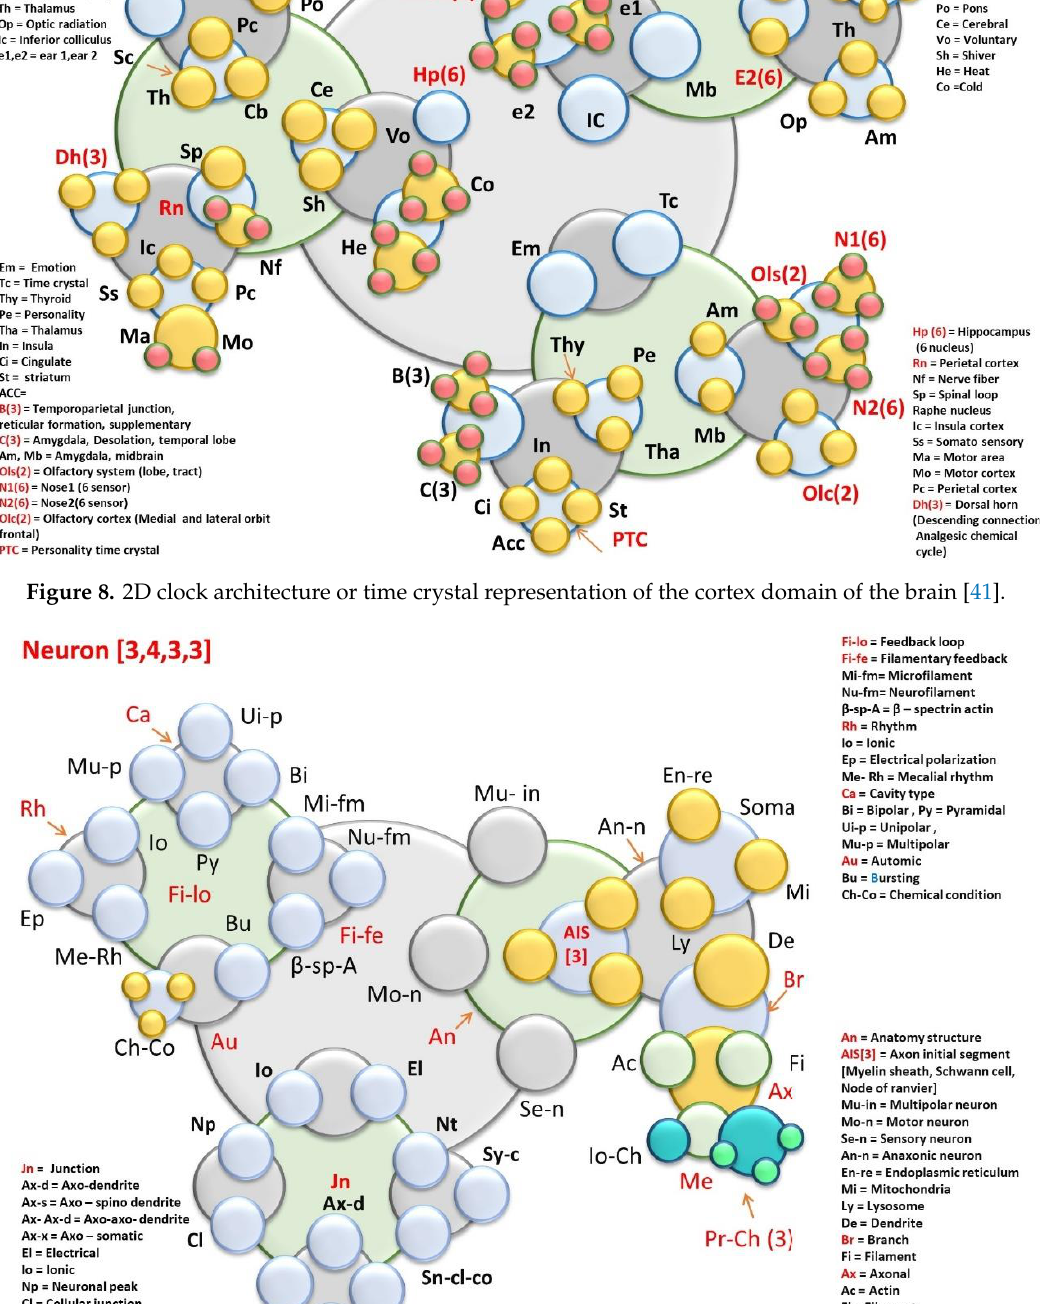
Figure 9. 2D clock architecture or time crystal representation of the neuron of the neural network [41].